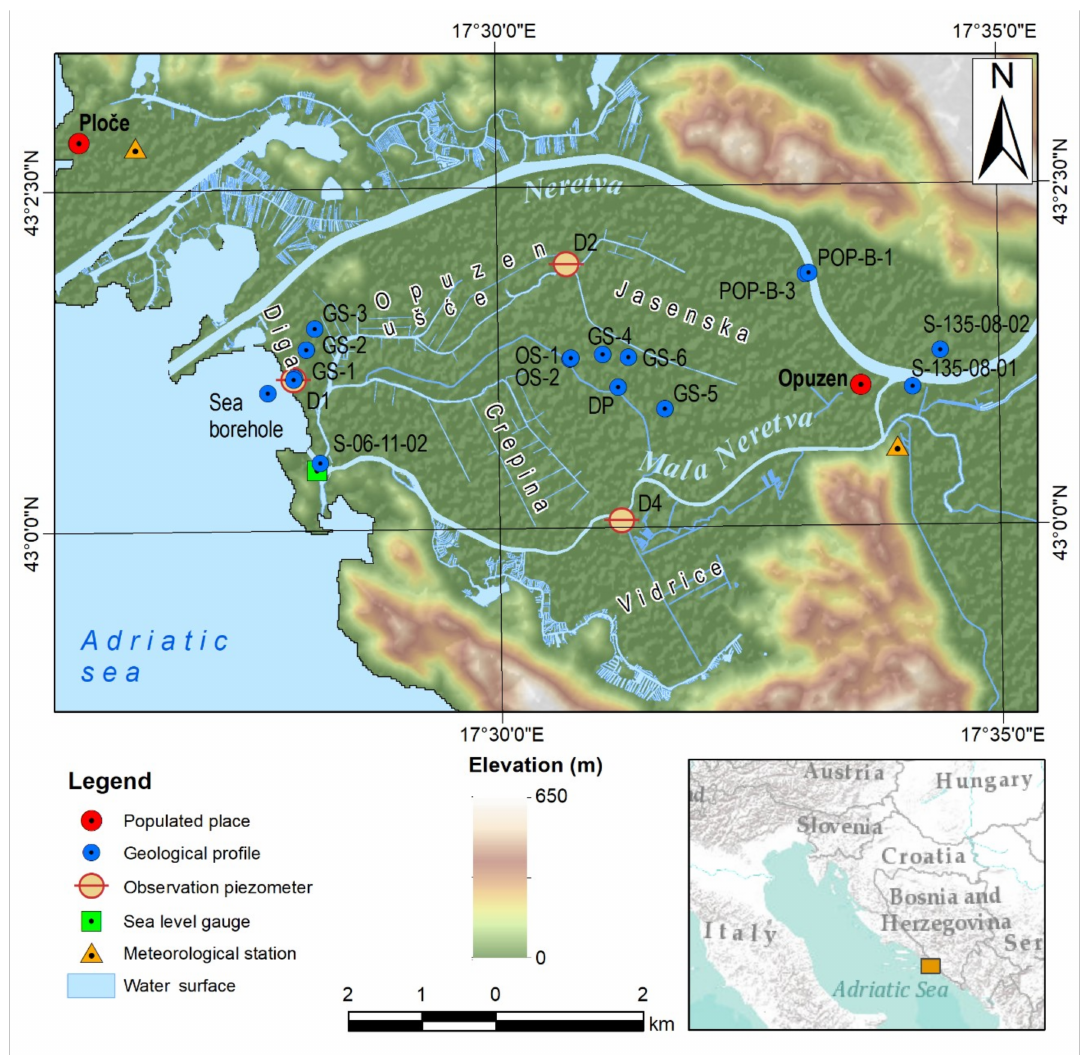
Figure 1. River Neretva Valley area of interest with locations of meteorological station, observation piezometers, sea level gauge, and geological